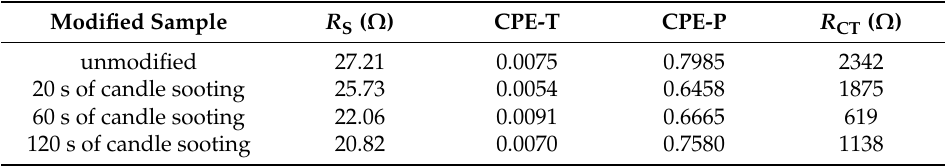
Figure 9. ( a ) Power density response curves and ( b ) EIS results of the MFCs configured with the unmodified and candle-soot-modified carbon cloths; ( c ) Equivalent circuit model. Table 1. R S , CPE-T, CPE-P, and R CT of the MFCs configured with the unmodified and 20-, 60-, and 120-s candle-soot-modified carbon cloth